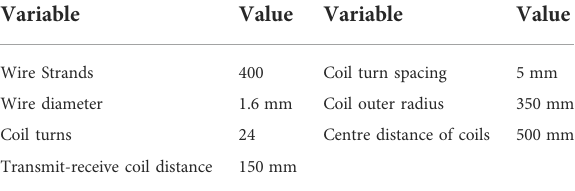
TABLE 1 Parameters of the MTMR WPT